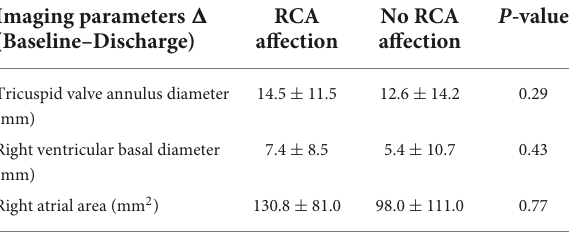
TABLE 3 Comparison of echocardiographic delta values in patients with RCA affection and patients without RCA alterations. Imaging parameters